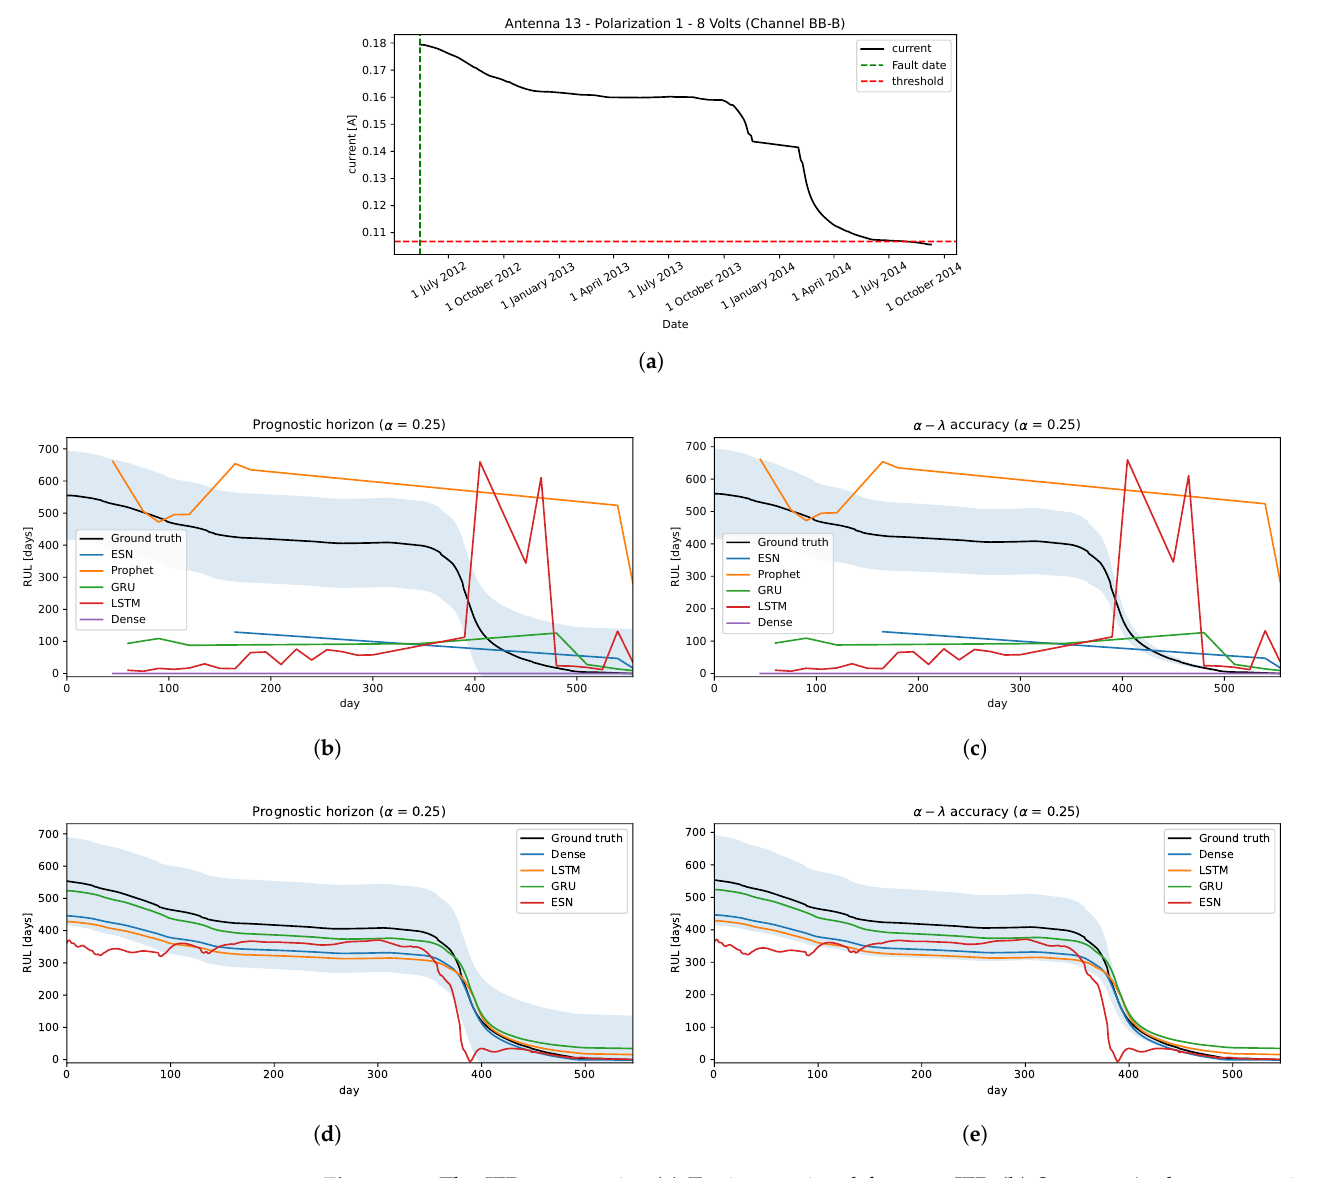
Figure 10. The IFP prognostic. ( a ) Testing: a signal from an IFP. ( b ) Strategy A: the prognostic horizon metric. ( c ) Strategy A: the α – λ accuracy metric. ( d ) Strategy B: the prognostic horizon